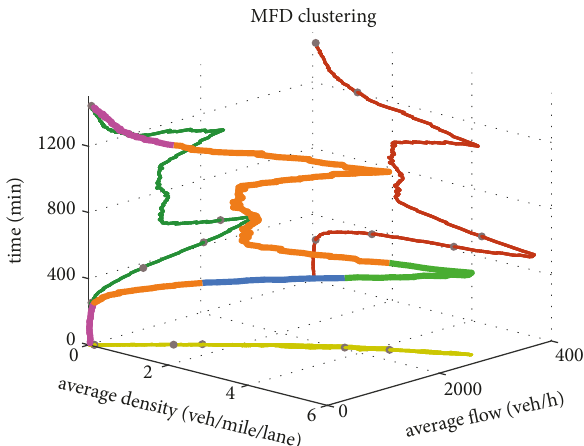
Figure 9: ATICC clustering result. Each color stands for one cluster with peak hours identified and captured.